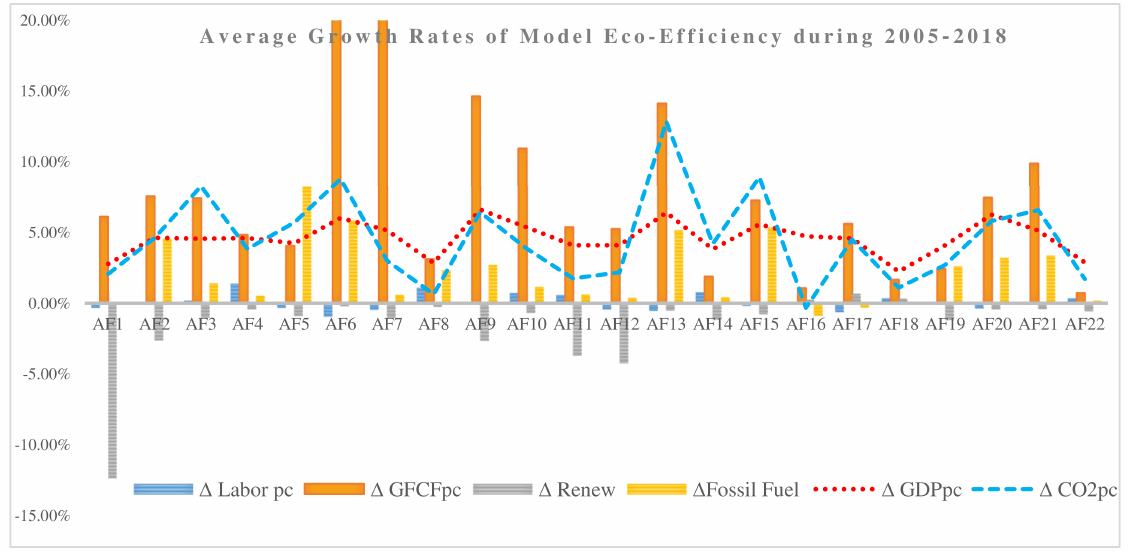
Figure 4. Average growth rates of the Eco-Efficiency indicator and their drivers for the 22 African